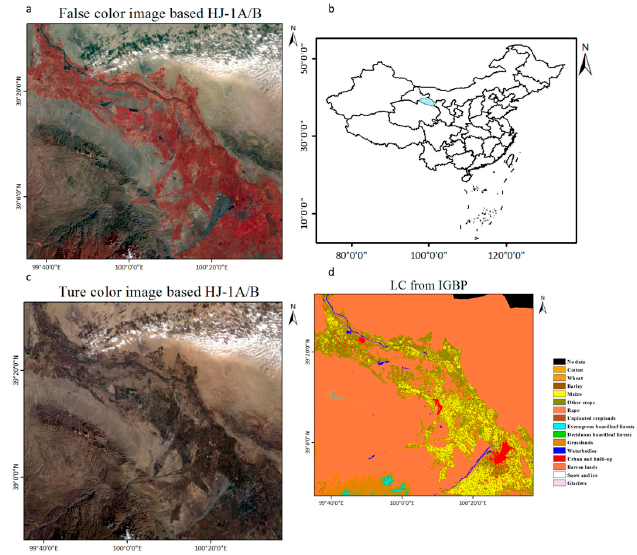
Figure 2. The Heihe River Basin study area is situated in Northwest China: ( a ) a false color image from 25 September 2012; ( b ) a map of China highlighting the location of the river basin; ( c ) a true color image from 25 September 2012; and ( d ) the land cover of the region in 2012.